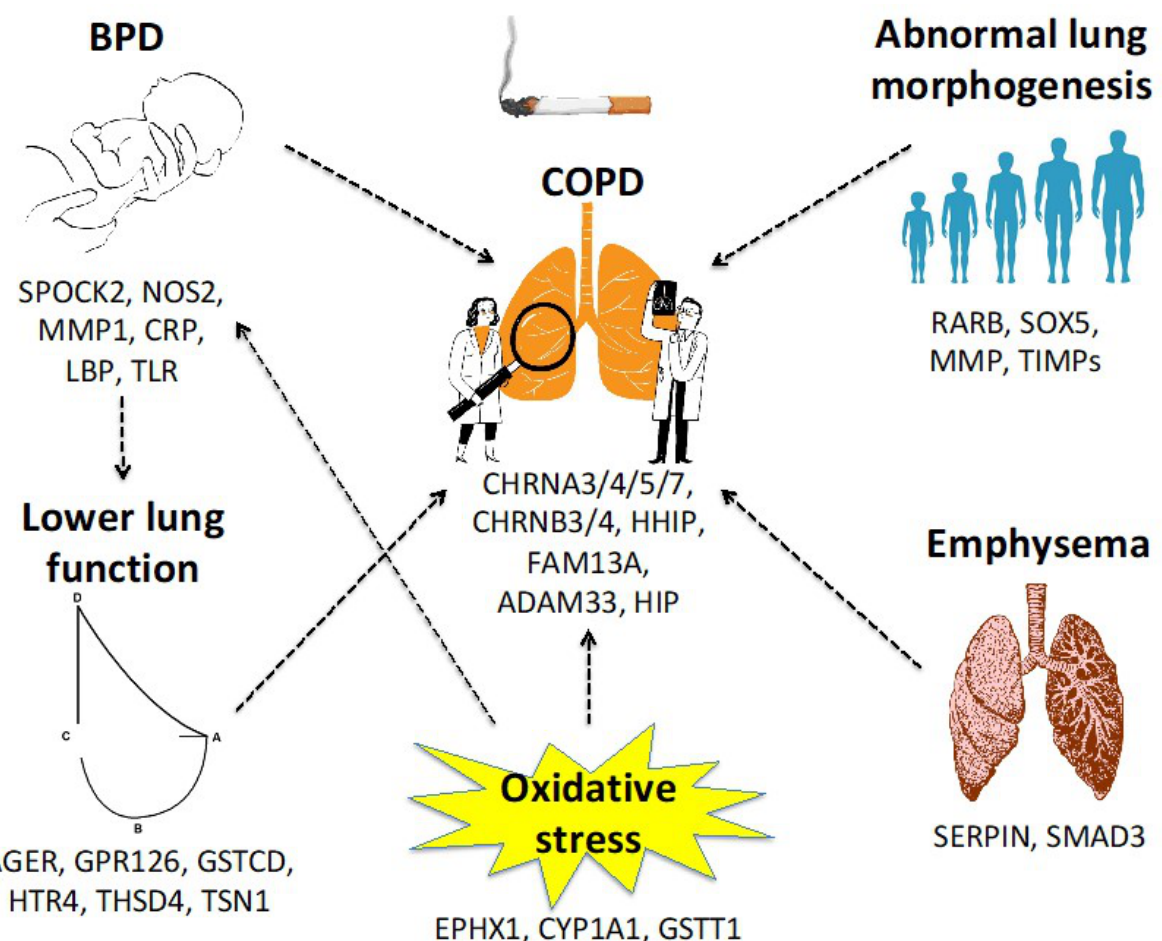
Figure 2. Genes that may be involved in COPD development directly or indirectly through other